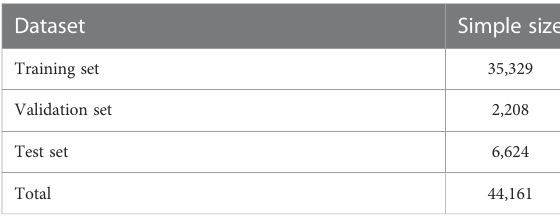
TABLE 1 Sample data used in the study.